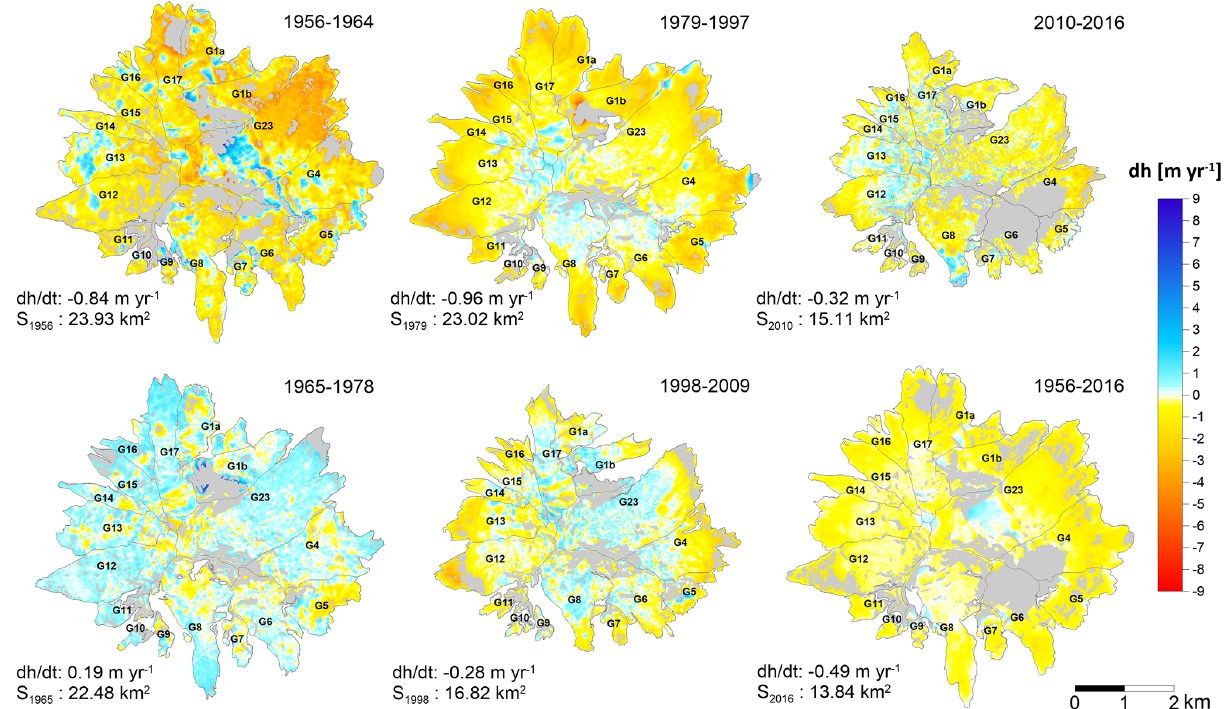
Figure 3. Spatial variability in changes in annual surface elevation of all glaciers on the Antisana ice cap in each study period. A decrease (increase) in the glacier surface elevation is shown by the red (blue) tone scale. The glacier boundaries in the first aerial survey are indicated by the grey lines, and areas for which no data are available are represented by the grey areas. The rate of elevation change and the surface area of the ice cap on the first date are given on the bottom left of each map (except for the last map illustrating the entire period for which the surface area measured on the last date is given as it is not mentioned elsewhere). All the maps have the same scale.